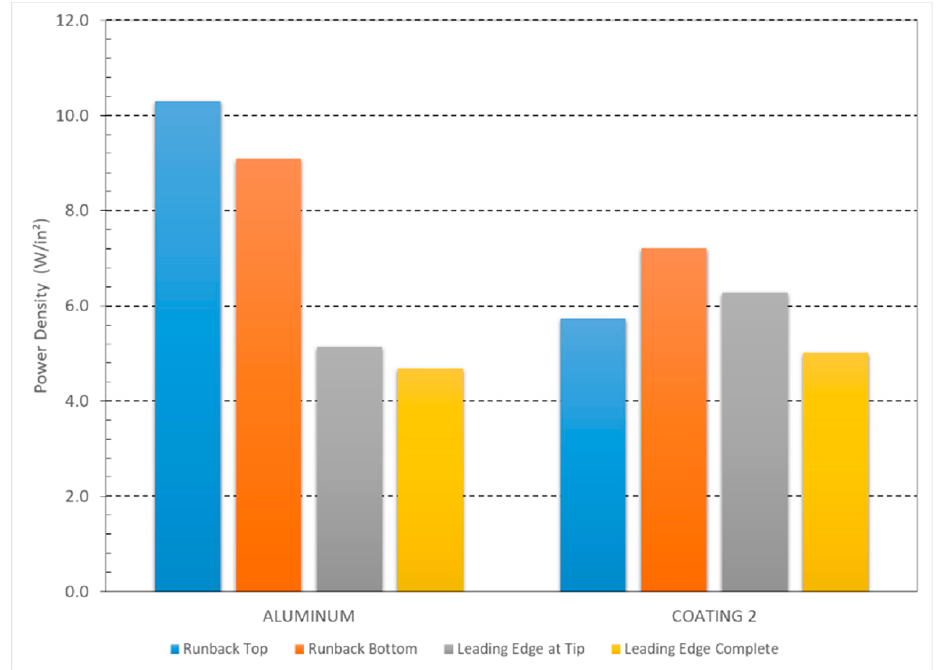
Figure 12. Power density obtained during anti-icing tests at − 15 °C measured when ice accretion is first initiated at different positions on the blade.